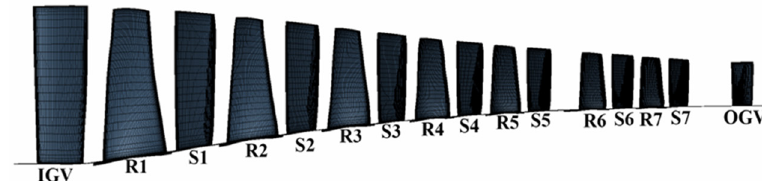
Figure 3. Overall mesh.